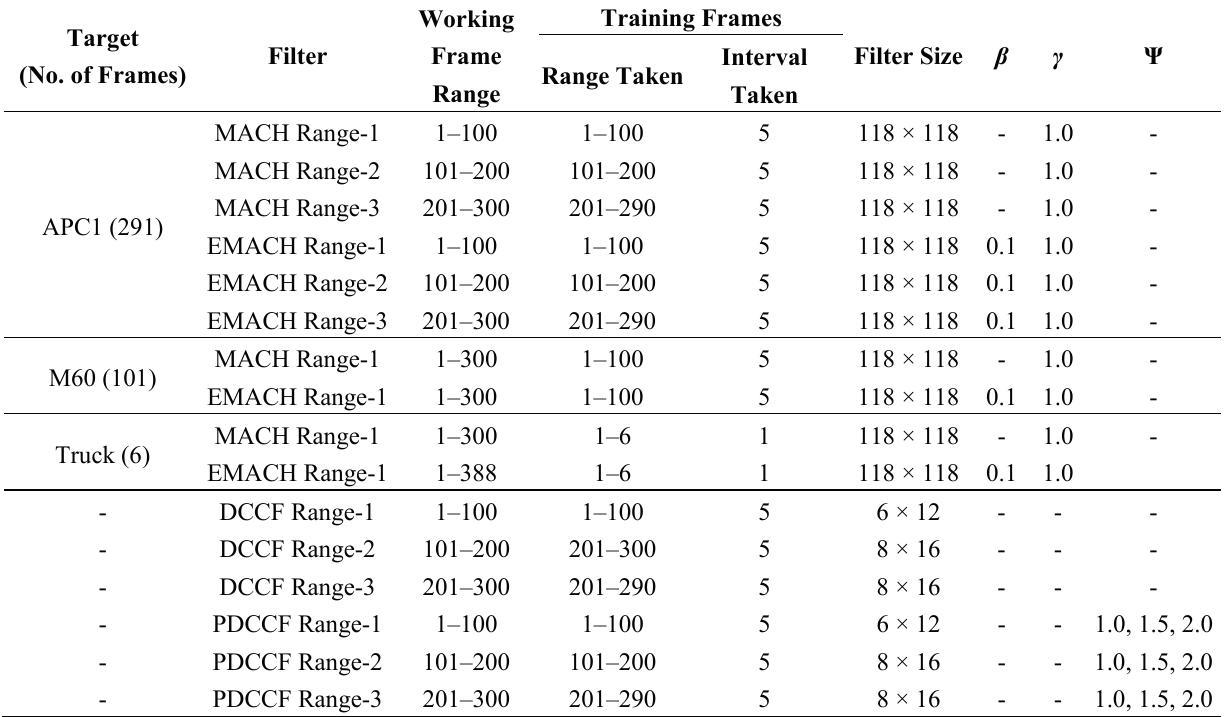
Table 9. Training data for Sequence